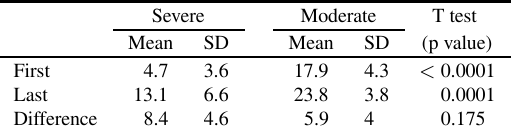
Table 7 Comparison of Token Test scores at fi rst and last evaluation of severe ( n = 10) and moderate subjects ( n = 12)